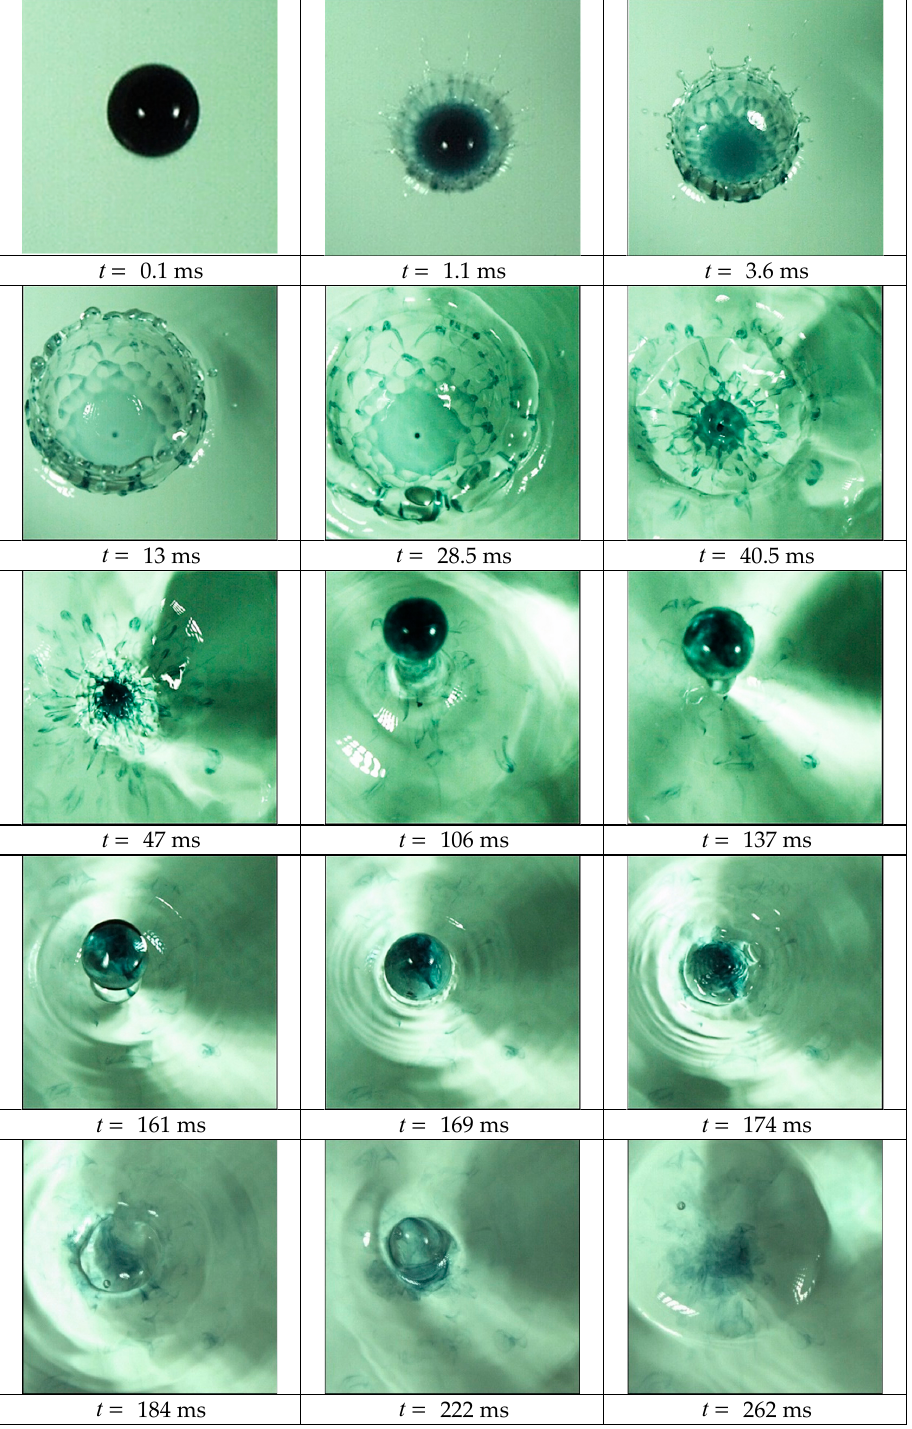
Figure 11. Frontal view of the impact flow produced by falling drop of an aqueous ink solution diluted at ratio 1:100 is coalescing with tap water ( D = 4.3 mm, U = 3.1 m/s, E σ = 4.0 mkJ, E k = 200 mkJ, Re = 13,300, Fr = 230, We = 570, Bo = 2.5, Oh = 0.0018, R E = E k / E σ = 50, R W = 7 × 10 − 5